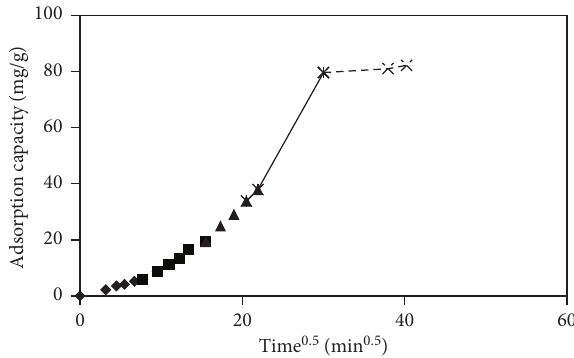
Figure 10: Intraparticle diffusion plot for the adsorption of methyl orange onto cross-linked chitosan beads.